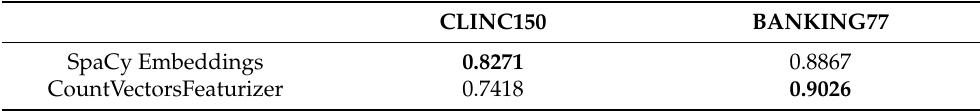
Table 1. Intent classification accuracy obtained through non-Transformer-based methods. Best performing models for each dataset have their results in